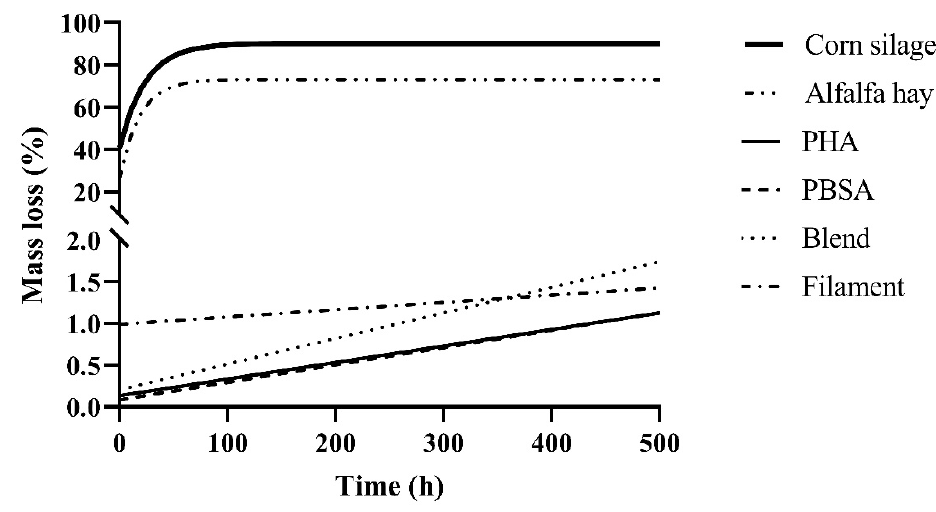
Figure 2. Projected degradation of forage controls alfalfa hay and corn silage and polymer treatments PHA, PBSA, Blend, and Filament. Projected degradation was determined from calculated disappearance kinetics parameters A and k as determined from the potential degradability equation (Table 1), where A is the immediate disappearance (%) at T = 0, and k is the fractional disappearance rate (%/h) of available material between T = 0 and T = 240. Kinetics parameters plotted for polymer treatments are mean values of those fermented in F57 and R510 bags in duplicate. Kinetics parameters plotted for forage controls are mean values of those fermented in only F57 bags in duplicate as bag type was significant.